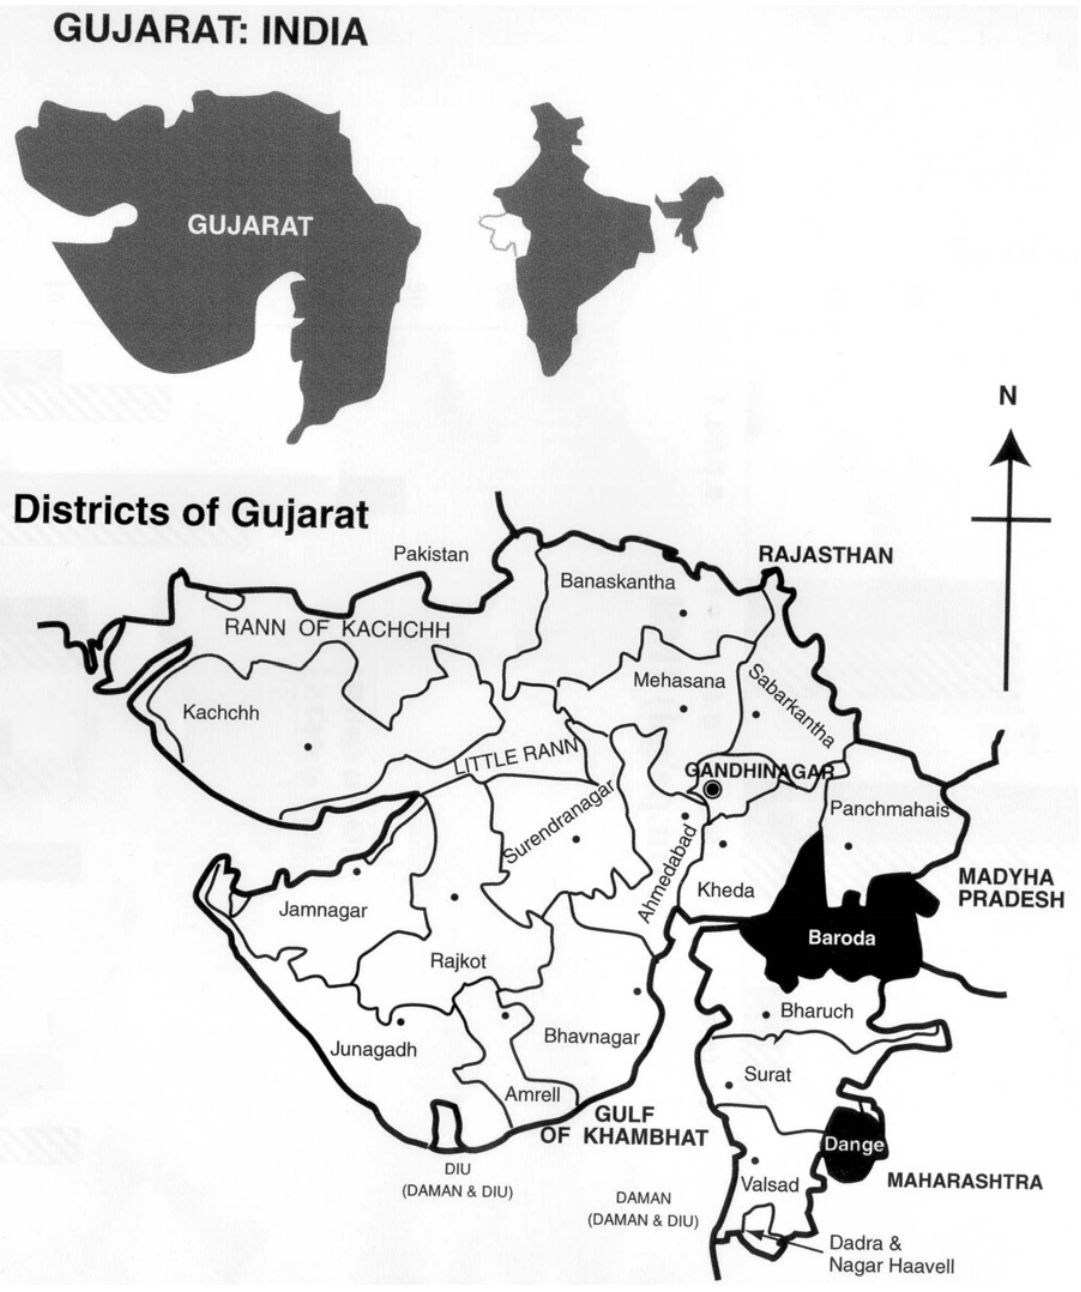
FIGURE 4. Map of Gujarat State, shown as a part of India, with the area of study — Baroda and Dang — as shaded districts. Vaghai, Rambhas, and Baripada villages in Dang district was approximately 70,000. We studied 472 subjects (aged 16 to 83 years; 245 men and 227 women) randomly by carrying out household surveys in Baroda (n = 392) and Dang (n = 80) districts (Table 1). The subjects were evenly distributed in different age groups and nearly equal numbers of males and females were included with a special emphasis to inclusion of females in the childbearing age group. Fifty-eight percent of men and 69% of women were above the age